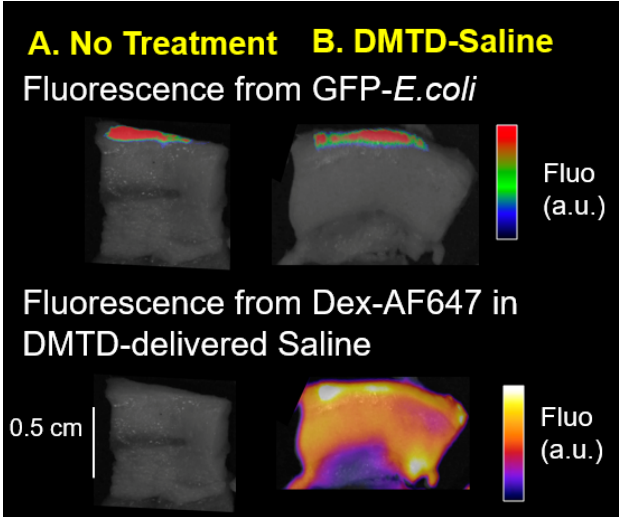
Figure 9. Representative images of ex vivo pig skin wounds infected with GFP- E. coli . The depth of GFP fluorescence was similar in wounds receiving 1 min delivery of 600 µL of DMTD-delivered saline ( B : n = 3) and the undisturbed wound ( A : no treatment: n = 3). DEX-AF-647 in the DMTD- delivered saline reached 5 mm depth in the skin indicating that the DMTD delivery was successful.